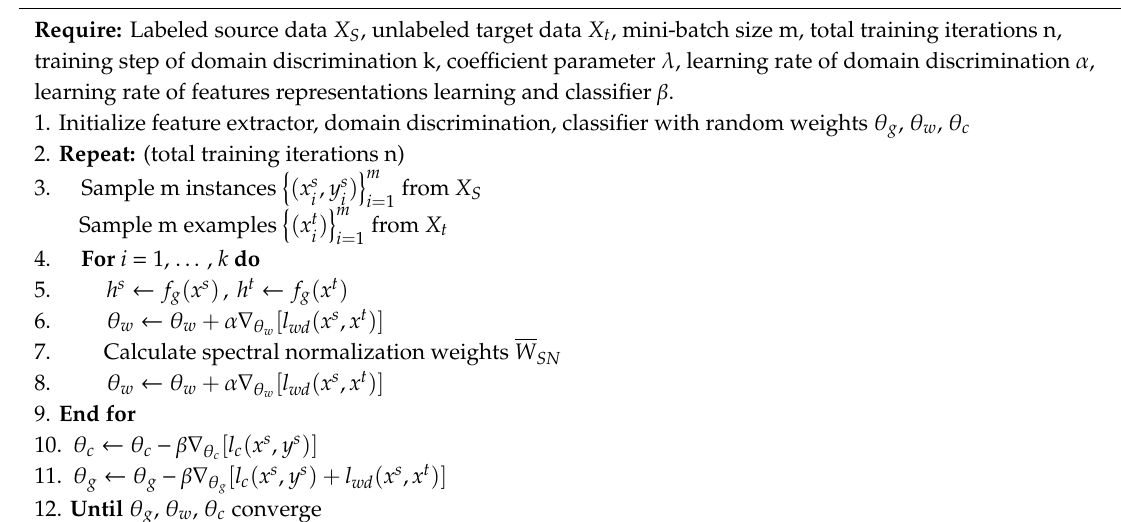
Algorithm 1 The Proposed WDLFR Method: Asserstein Distance Learned Feature Representations Combining with